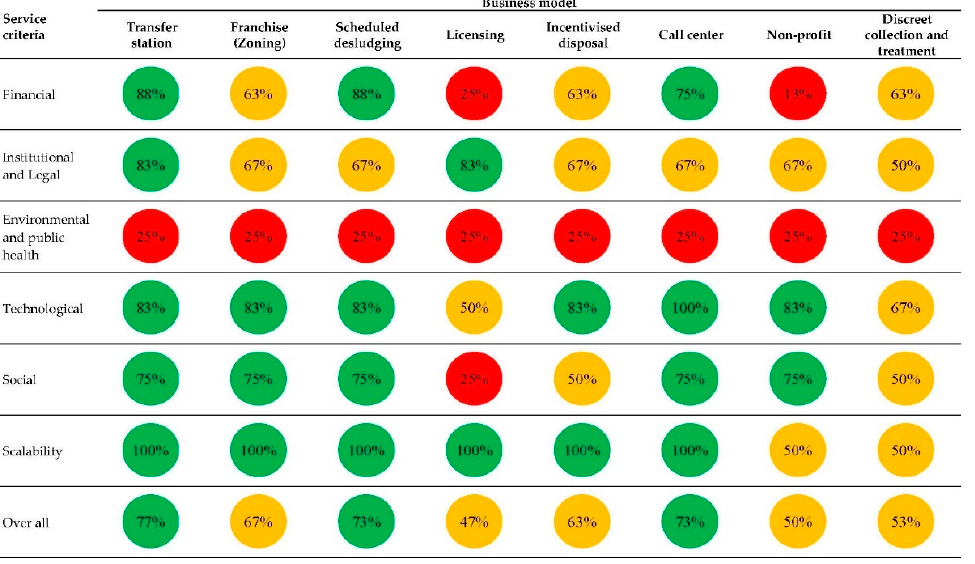
Figure 3. Business model scorecard for gulper (Supplementary material S3)